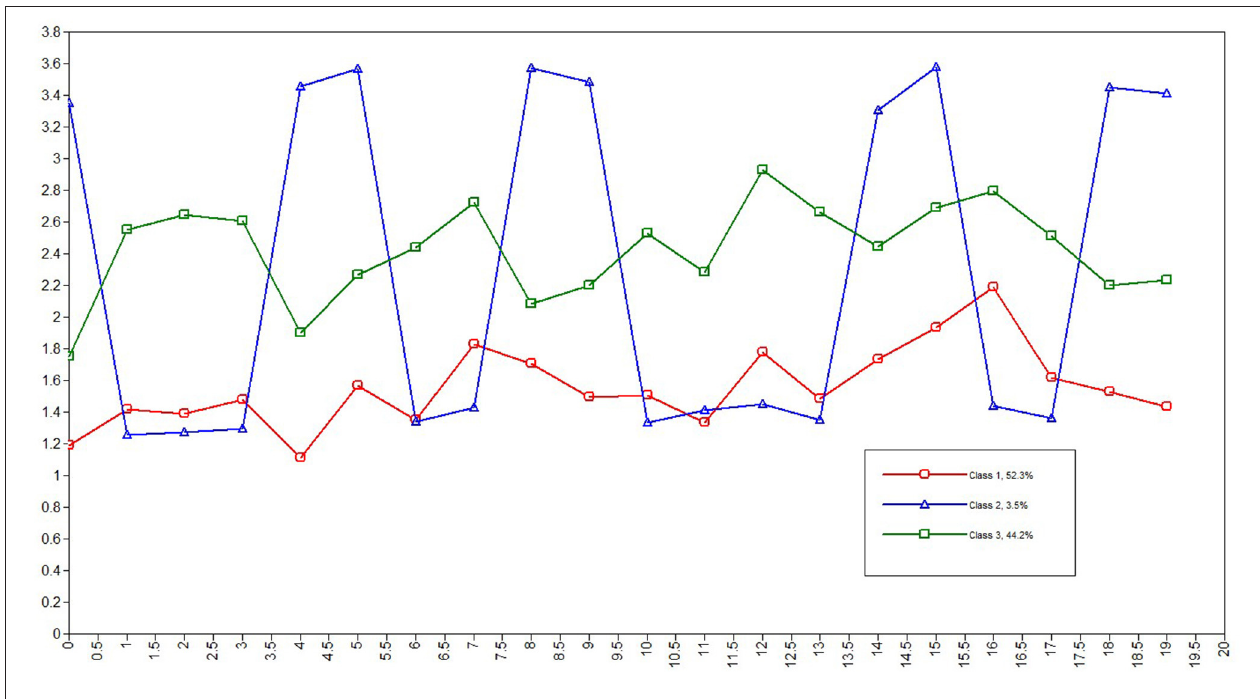
FIGURE 1 | Latent Profile of